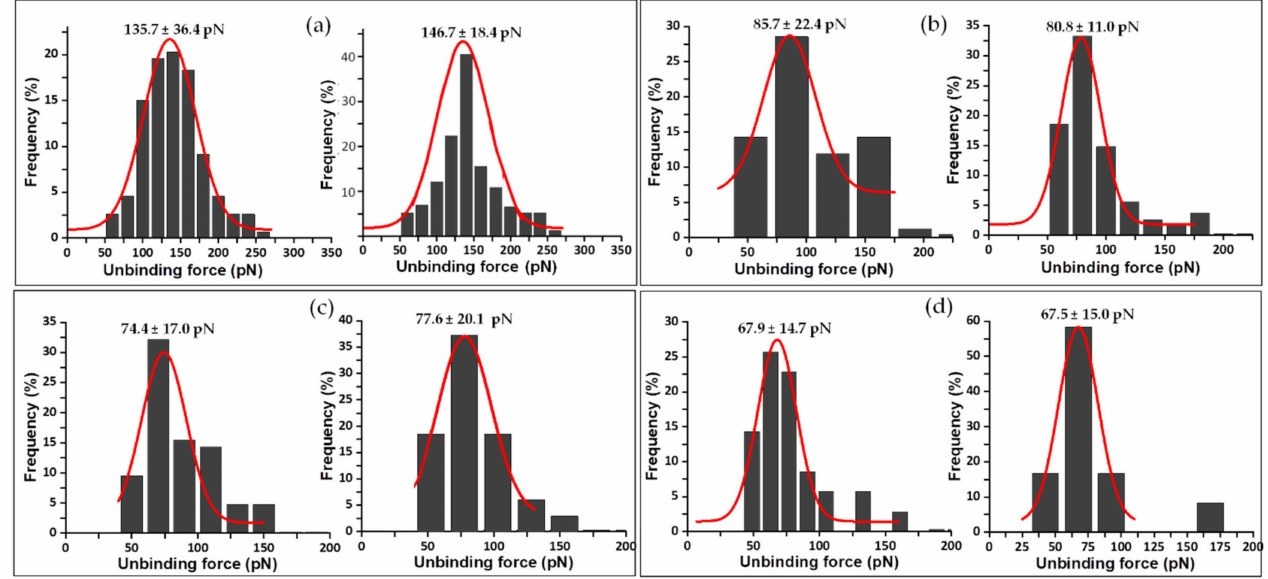
Figure 10. Control experiments showing histograms obtained at R 10 nN/s for AnFNR ox :NADP + complexes and the corresponding blocked samples with excess ligand. Unbinding force data